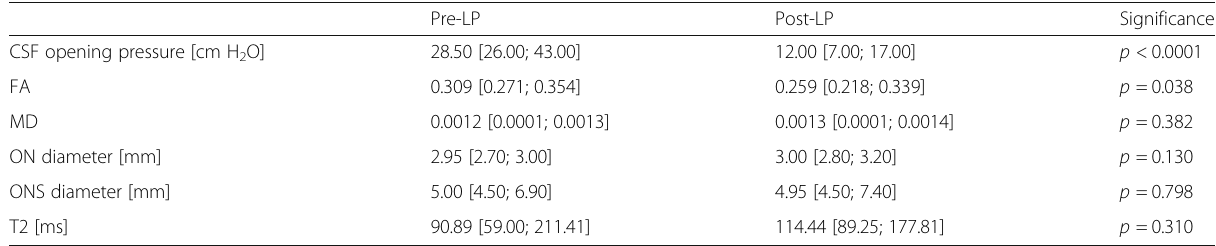
Correlation of imaging parameters with clinical parameters The change of the headache intensity before and after lumbar puncture did not correlate with the change in the FA values of the optic nerve ( r = − 0.626, p = 0.097) (Fig. 4) or with the change of the T2 values measured of the optic nerve ( r = − 0.754; p = 0.084). Furthermore, no correlations were observed between the difference of CSF pressure before and after lumbar puncture with the change of the FA ( r = 0.323; p = 0.435) (Fig. 4) and T2 values ( r = − 0.314, p = 0.544) of the optic